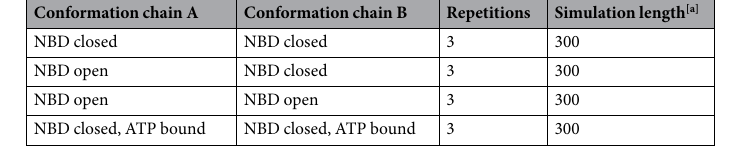
Table 1. MD simulations of the PPDK dimer. [a] In